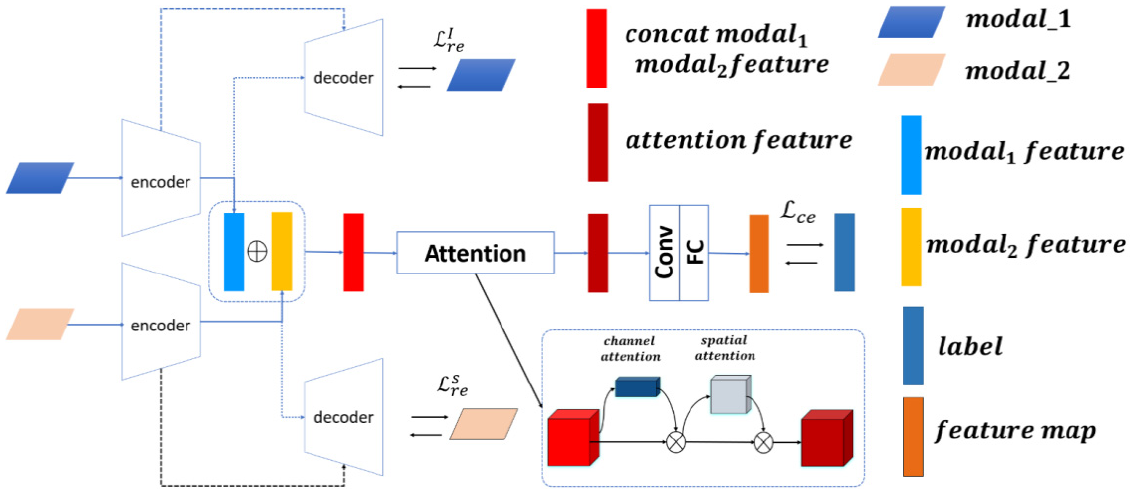
Figure 8. Multimodal fusion network.